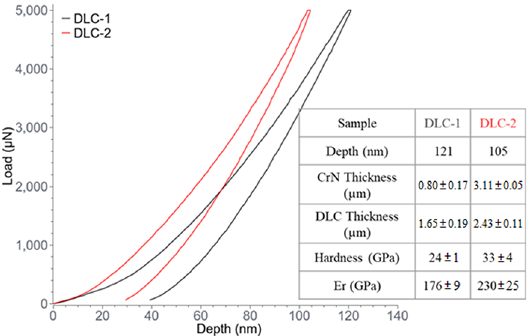
Figure 4. Load-displacement curves for DLC-1 and DLC-2